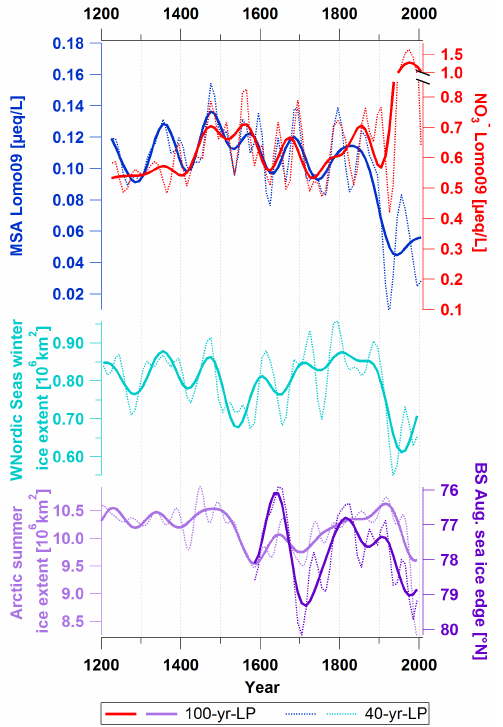
Figure 6. Records of Lomo09 MSA (dark blue), pre-industrial NO − (red), western Nordic Seas winter (April) ice extent 3 (turquoise; Macias Fauria et al., 2010), Arctic summer (August) sea-ice extent (light purple; Kinnard et al., 2011), and August sea- ice edge position in the Barents Sea (BS; dark purple; Kinnard et al., 2011). Bold lines are 100-year lowpass-filtered (100-yr-LP); dashed lines are 40-year lowpass-filtered